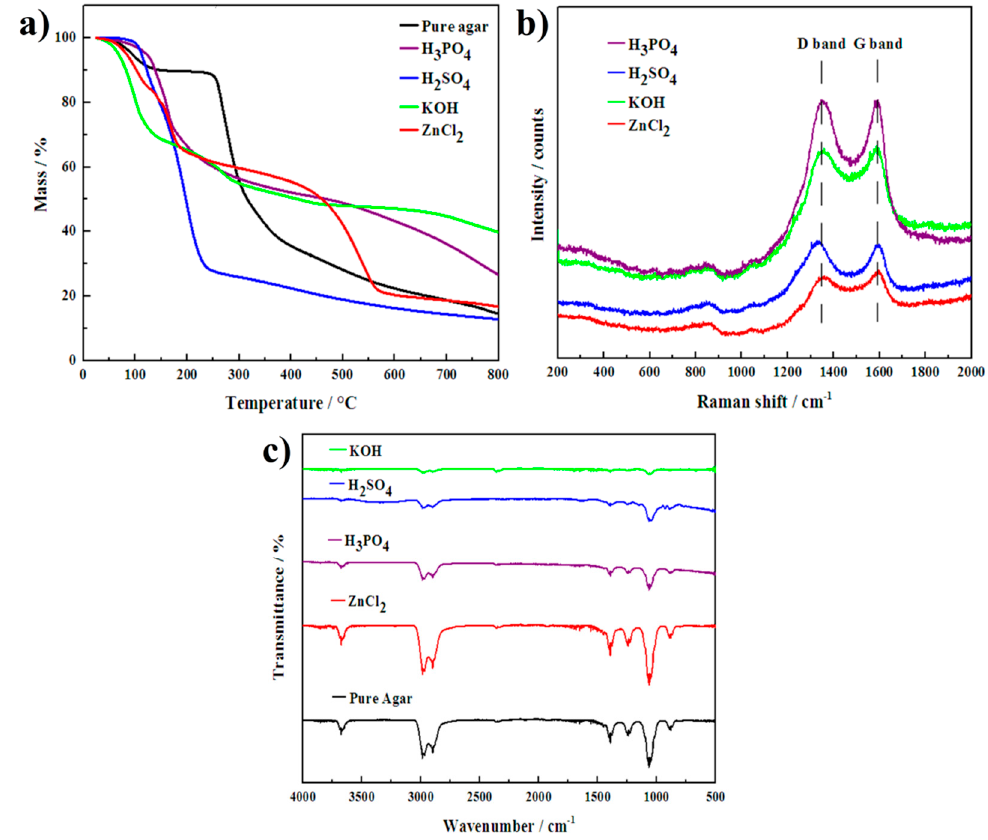
Figure 2. ( a ) TGA curves of pure agar and hydrogels with different activating agents; ( b ) Raman spectra of obtained carbons; ( c ) FT-IR spectra of pure agar and obtained carbons.